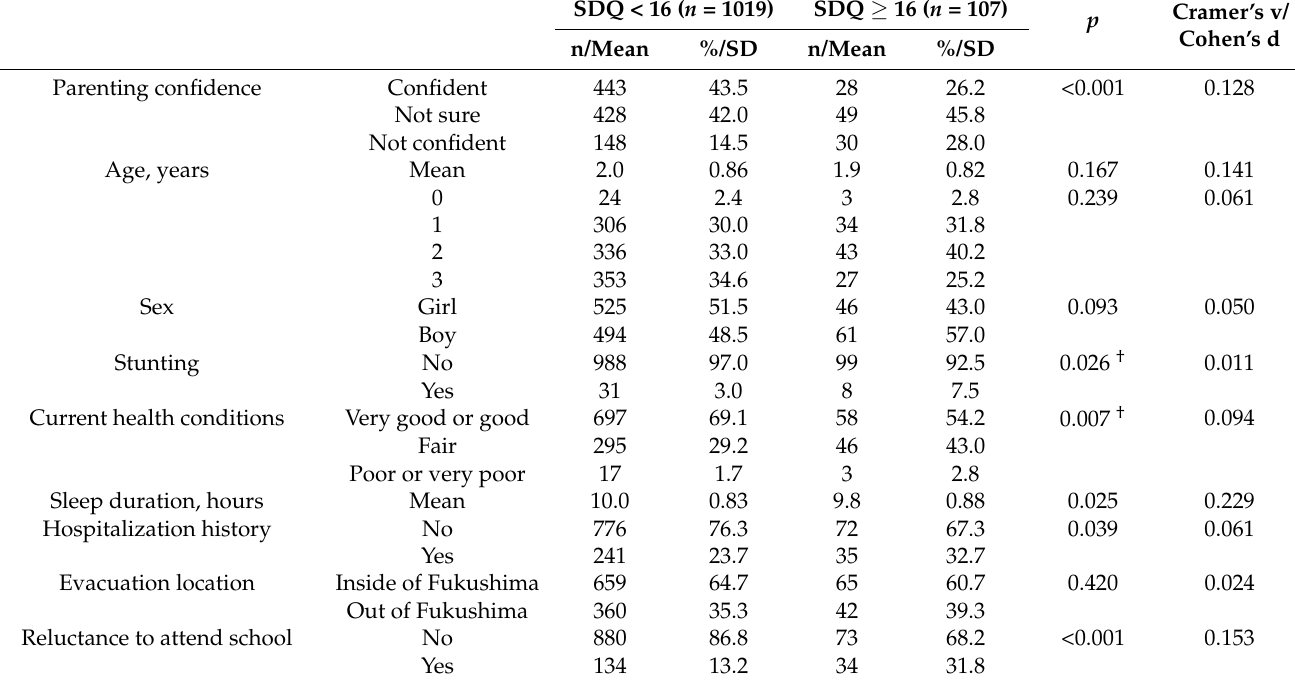
Table 1. Characteristics of the participants ( n =